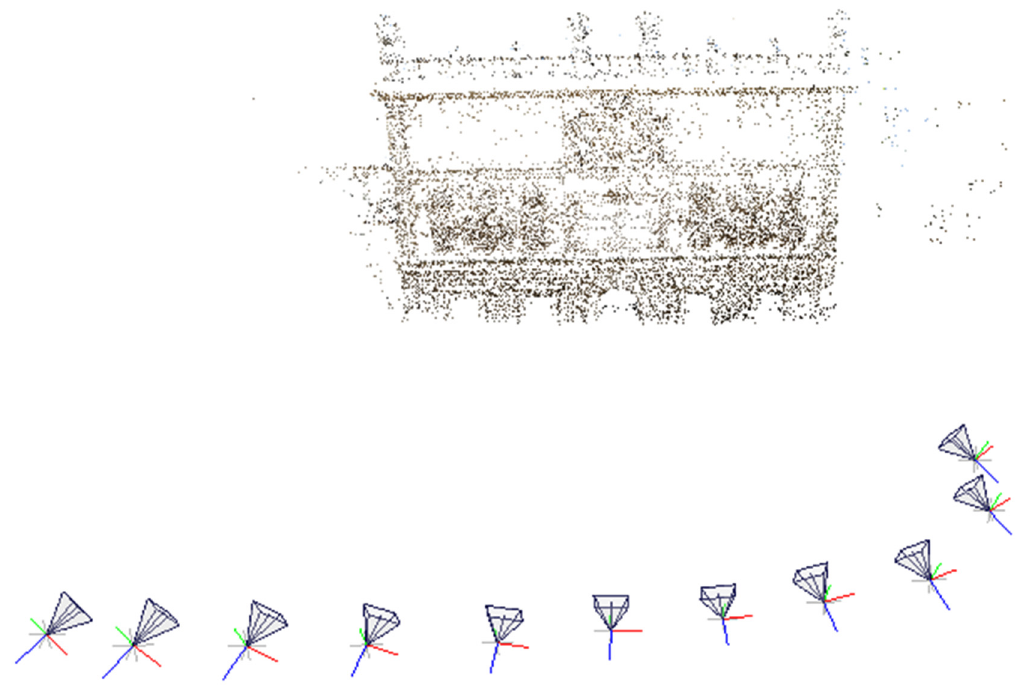
Figure 12. Sparse point clouds of the Hotel sequence, generated by Visual SfM with the HashMatch method.